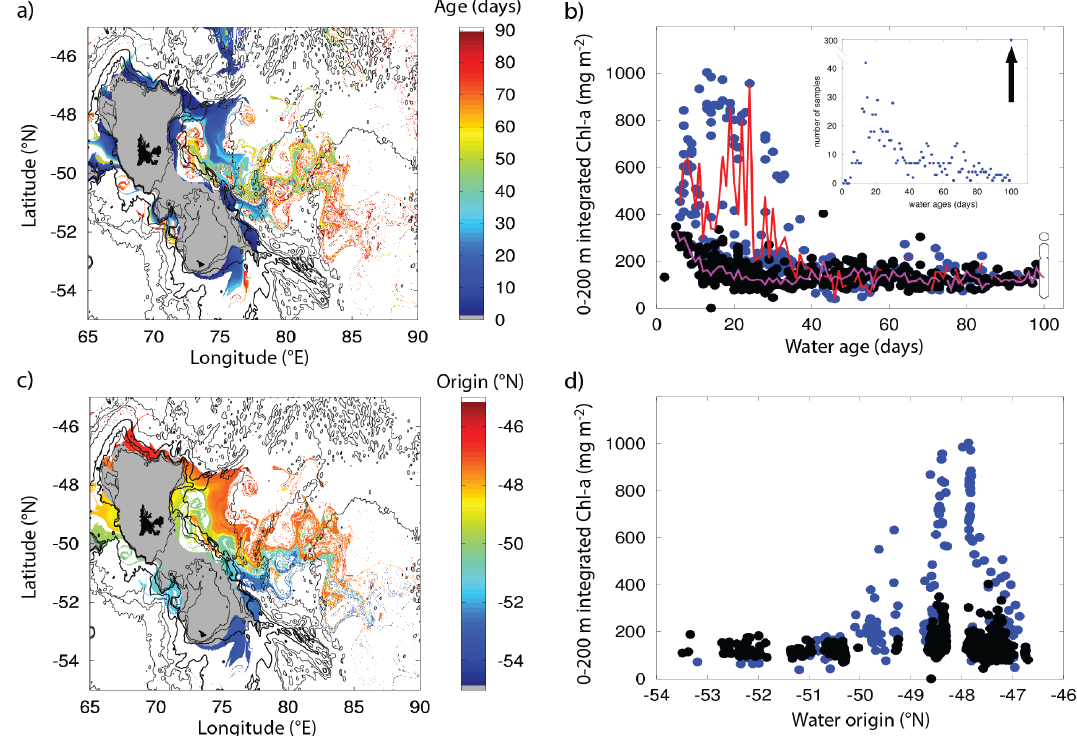
Figure 11. Lagrangian diagnostics computed from altimetry. Maps of age and origins of the water parcels shown in plots (a) and (c) are from Fig. 4 of d’Ovidio et al. (2015). White pixels represent water parcels that have not touched in the past 100 days the Kerguelen Plateau (defined by the 700m isobath and shown in grey). Comparison of these age and origin metrics with the bio-profiler total integrated Chlorophyll a values are shown in plots (b) and (d) . Blue dots correspond to data collected during spring (bio-profiler #1; mean values in red) and black dots to data collected during summer (bio-profilers #2, #3, and #4; mean values in magenta). White dots correspond to water parcels that have not touched the Kerguelen Plateau. The inset in plot (b) shows the number of measurements for each water age. The black arrow highlights the fact that low Chl a levels associated with water parcels that have not touched the Kerguelen Plateau within the last 100 days are supported by a large number of samples and, thus, seem to be a robust